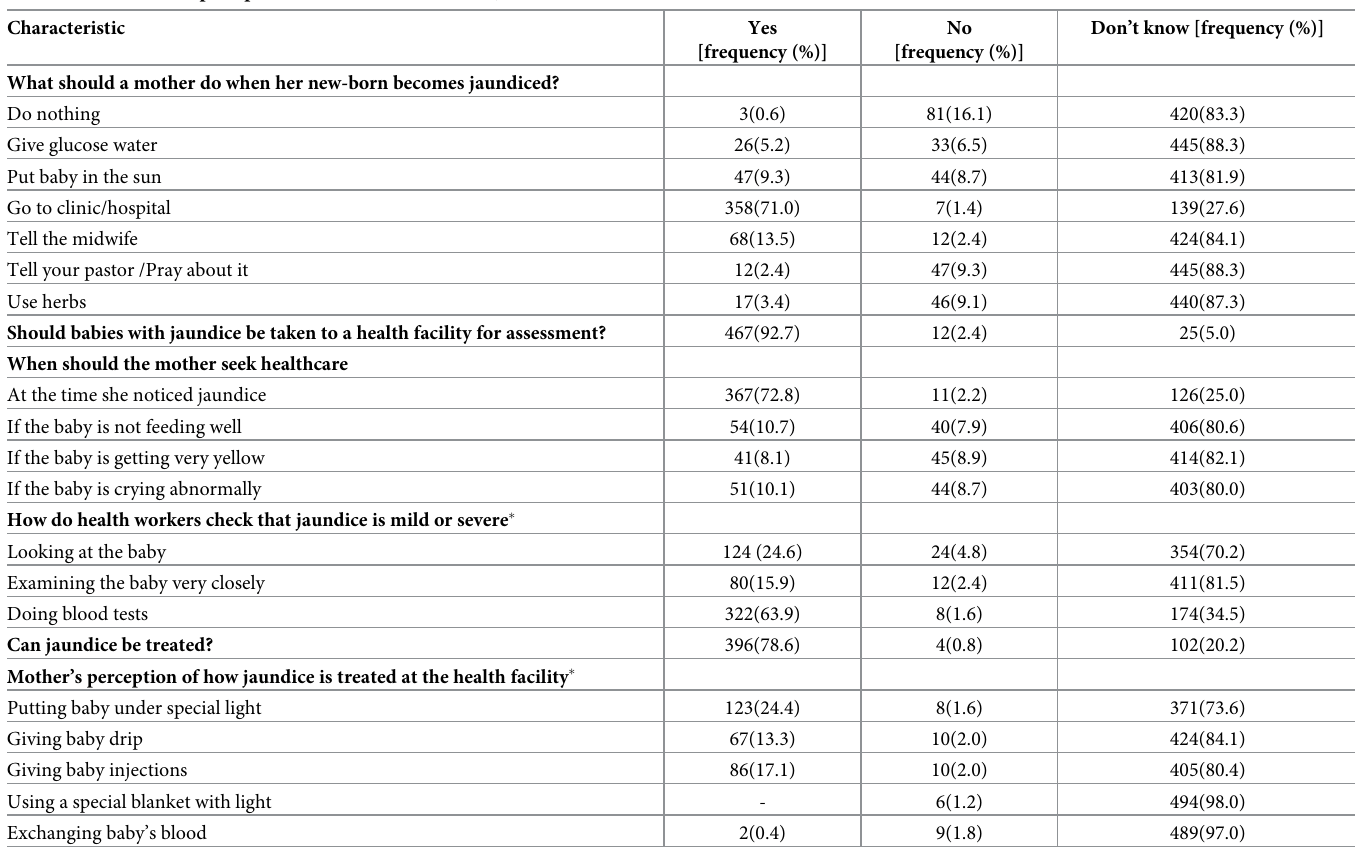
Table 3. Attitudes and perceptions of mothers towards